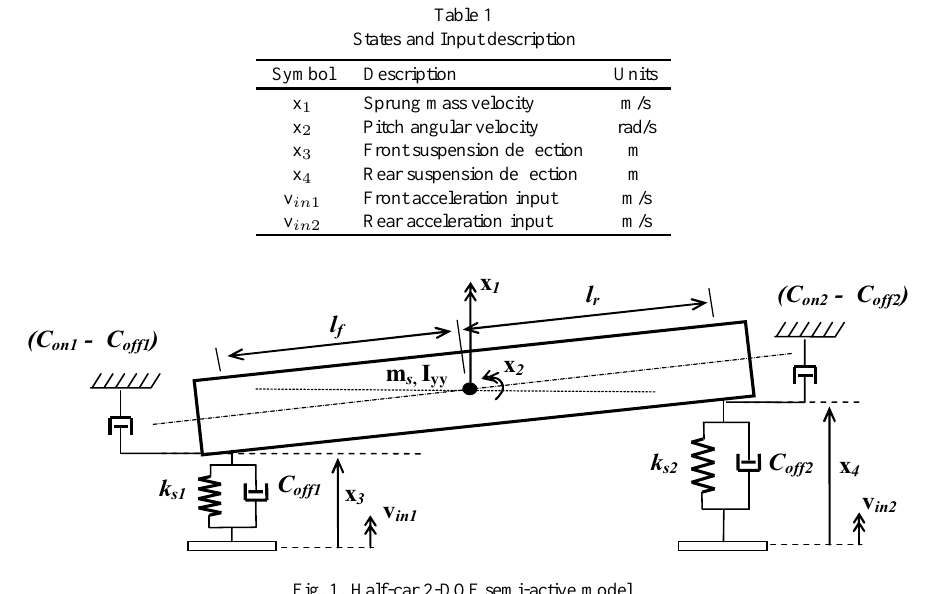
Fig. 1. Half-car 2-DOF semi-active